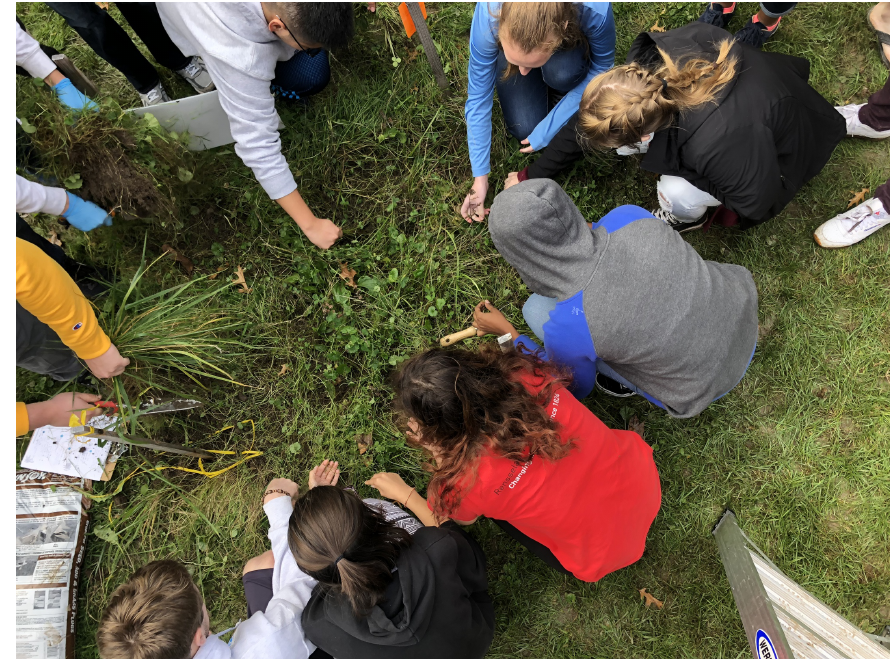
Figure 16: Fieldwork and plot redomestication at Lawn Lab plot #4 (Nason Hall at Rensselaer Polytechnic in collaboration with Vasudah Living and Learning Community), October